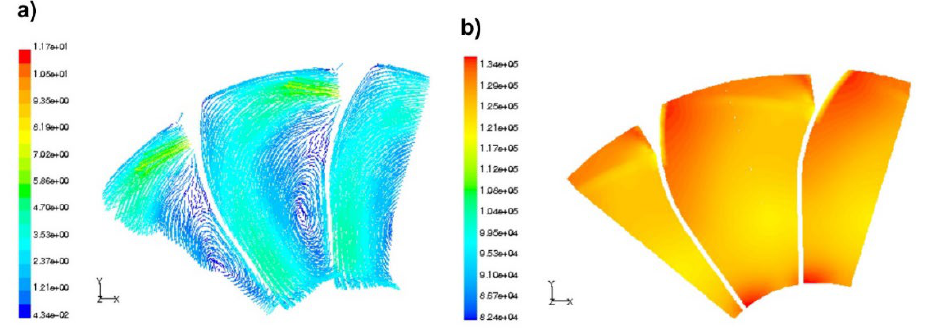
Figure 21. The field of: ( a ) velocity [m/s]; ( b ) static pressure [Pa] in the channels of the guide vanes for variant z k = 11.